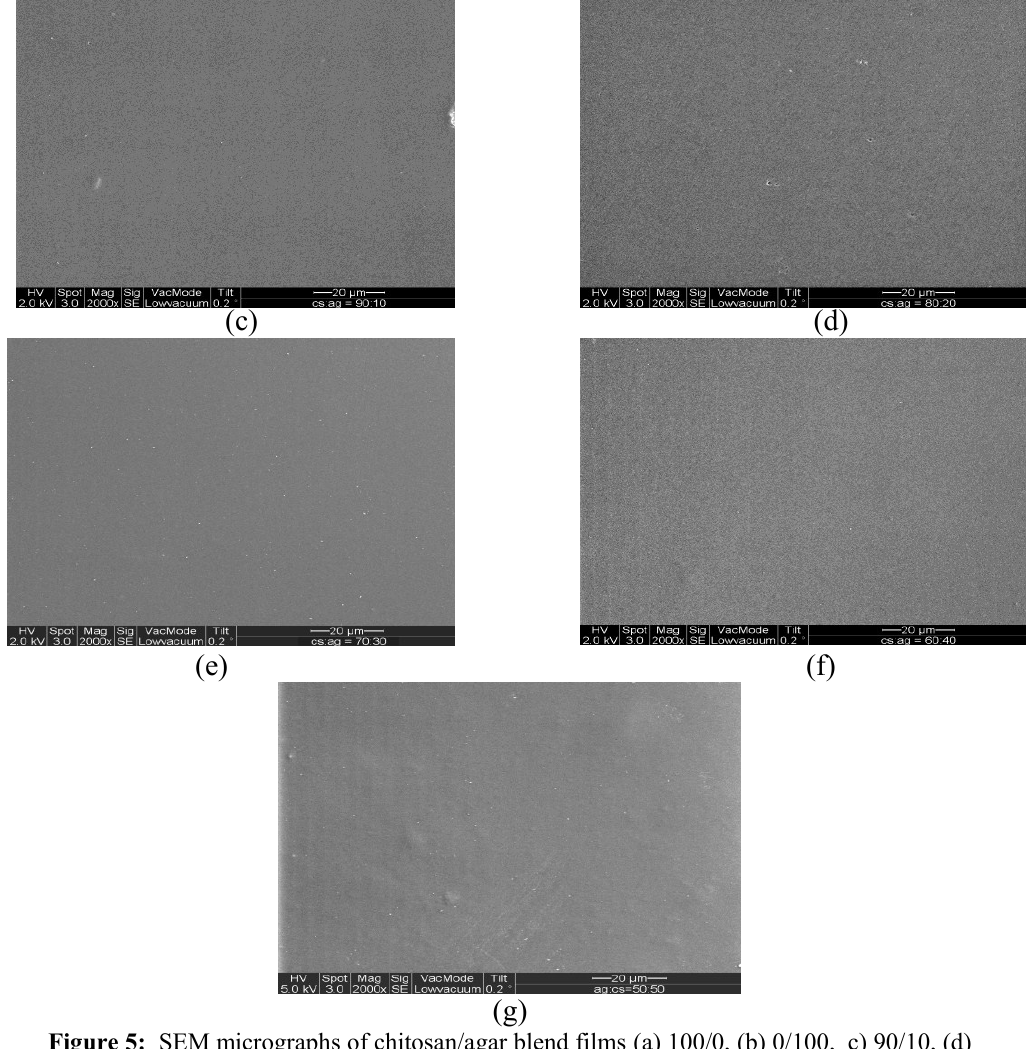
Figure 5: SEM micrographs of chitosan/agar blend films (a) 100/0, (b) 0/100, c) 90/10, (d) 80/20, (e) 70/30, (f) 60/40 and (g)